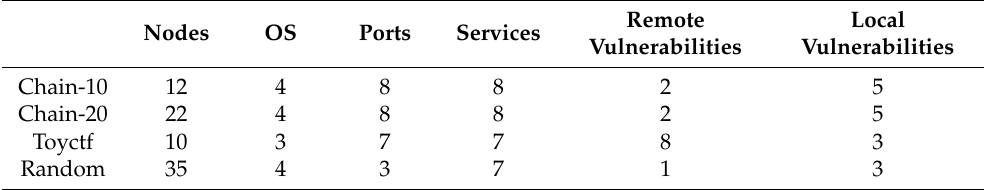
Table 3. The list of network scenarios.